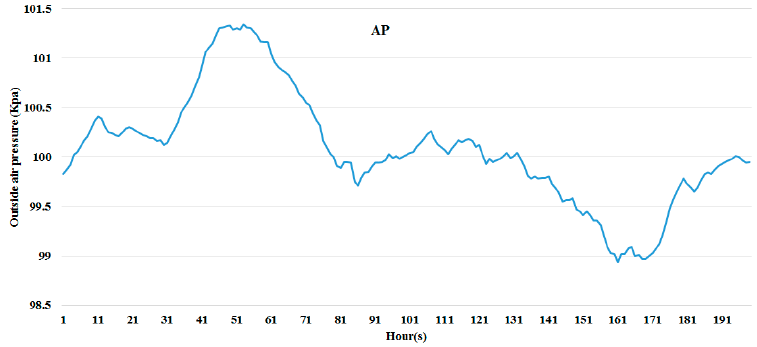
Figure 6. Outside air pressure data information (kPa).